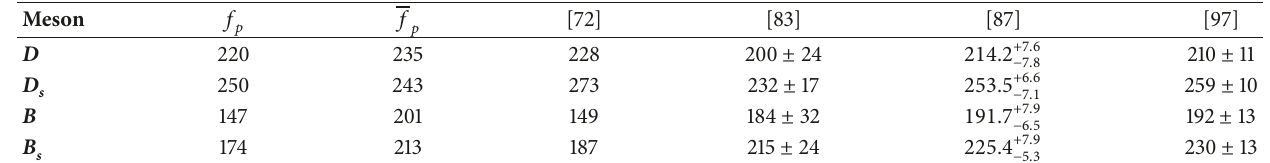
Table 7: The decay constants of pseudoscalar B and D mesons in MeV.